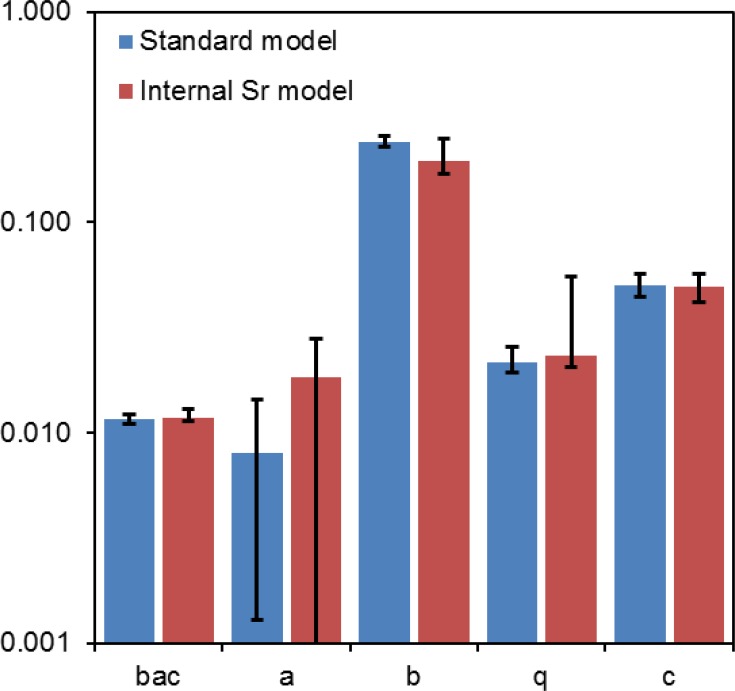
Exploration of model parameter uncertainties by MC simulation which included random variability in dose rate estimates and aberration counts.The bars represent best-fit parameter values for the standard (blue) and internal Sr models (red). Parameter interpretations and units are provided in Table 1. Error bars represent 95% CIs. The best-fit parameter values for the standard model were: bac = 0.0117 (95% CI: 0.0110, 0.0122), a = 0.0080 (0.0013, 0.0143) year/Gy, b = 0.242 (0.228, 0.259), q = 0.0216 (0.0193, 0.0255) Gy/year, c = 0.0506 (0.0440, 0.0570) year-1. For the internal Sr model they were: bac = 0.0117 (0.0114, 0.0130), a = 0.0183 (0, 0.0279) year/Gy, b = 0.197 (0.169, 0.252), q = 0.0234 (0.0205, 0.0551) Gy/year, c = 0.0498 (0.0415, 0.0570) year-1. Details are described in the main text.